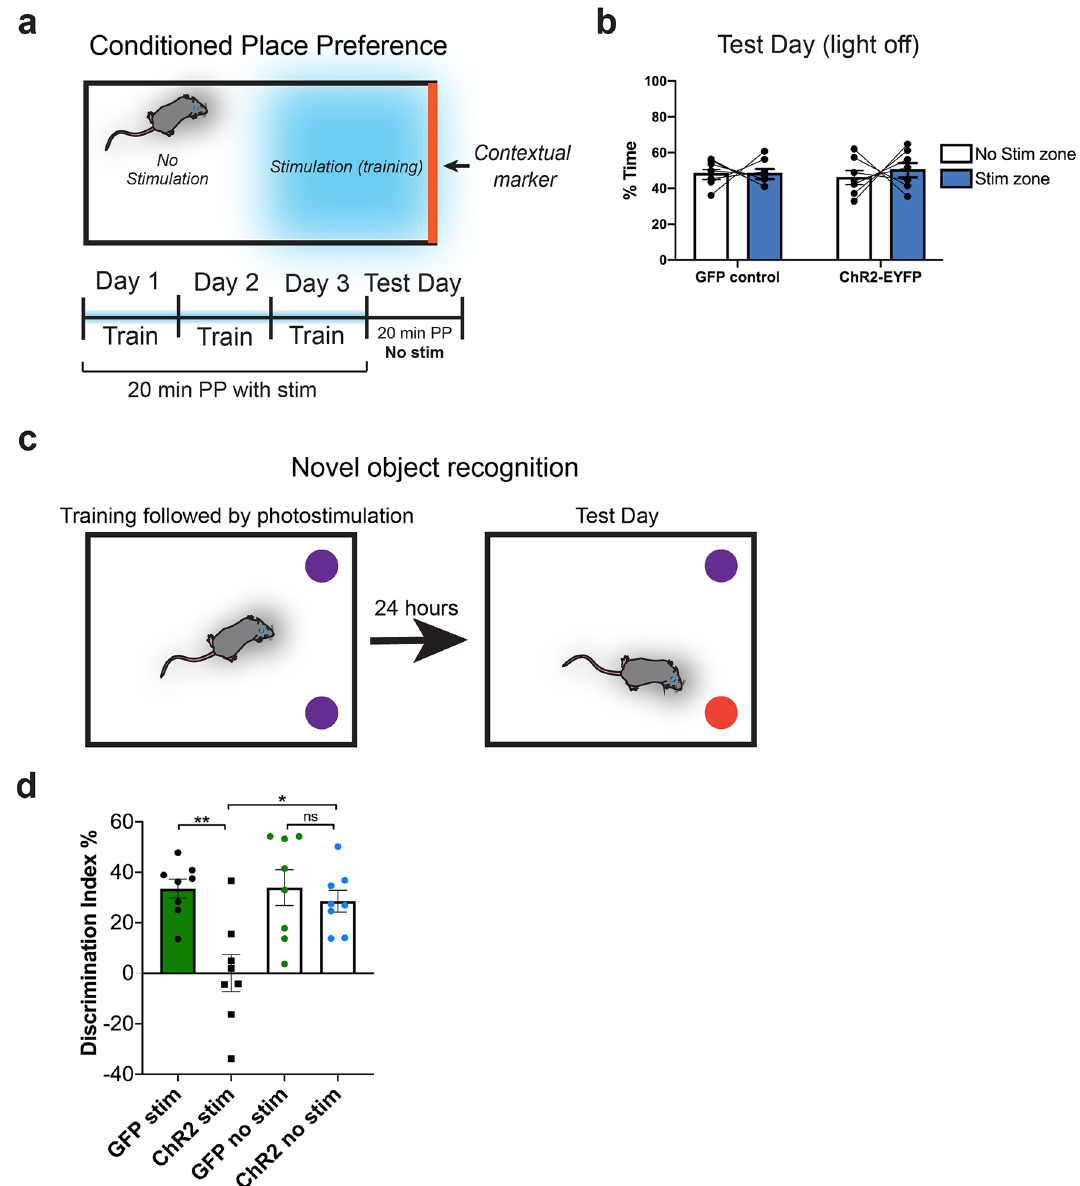
Figure 4. Optogenetic stimulation of basal forebrain-to-lateral habenula circuitry impairs memory formation. ( a ) Contextual conditioned place preference experimental paradigm with optogenetic stimulation. ( b ) Average percent time GFP and ChR2-EYFP optogenetic animals spent in either side of the contextual conditioned place preference arena on test day, without photostimulation. Statistical significance determined using Binomial test for proportion with Bonferroni correction; null hypothesis = 50%. Error bars represent SEM. n = 7. For GFP controls, they spent 48.66 ± 2.798% in non-stim zone, 48.7 ± 2.83% in stim zone, p = 0.99. For ChR2 animals, they spent 46.43 ± 3.958% in non-stim side, 50.78 ± 4.07% in stim side, p = 0.6137. ( c ) Novel object recognition experimental paradigm. In the photostimulation version of this paradigm, mice were photostimulated (20 Hz, 5 ms pulses) for 10 min after a 10 min training session with two identical objects. One day later, mice were tested on how well they discriminated between one novel and one familiar object. ( d ) Discrimination index (calculated as: [(time investigating novel object – time investigating familiar object)/ total investigation time]*100) on test day of novel object recognition. A discrimination index over 0 indicates a preference for investigating a novel object, as expected. DI for GFP stimulation = 33.53 ± 3.80%. DI for ChR2 stimulation = 0.049 ± 7.38%. DI for GFP no stimulation = 33.91 ± 7.13%, DI for ChR2 no stimulation = 28.55 ± 4.29%. Statistical significance calculated using a repeated measures Two-way ANOVA with a Bonferroni multiple comparisons correction. GFP stim vs ChR2 stim p = 0.0023. GFP no stim vs ChR2 no stim p = > 0.9999. ChR2 stim vs ChR2 no stim p = 0.0113. GFP stim vs GFP no stim p = >